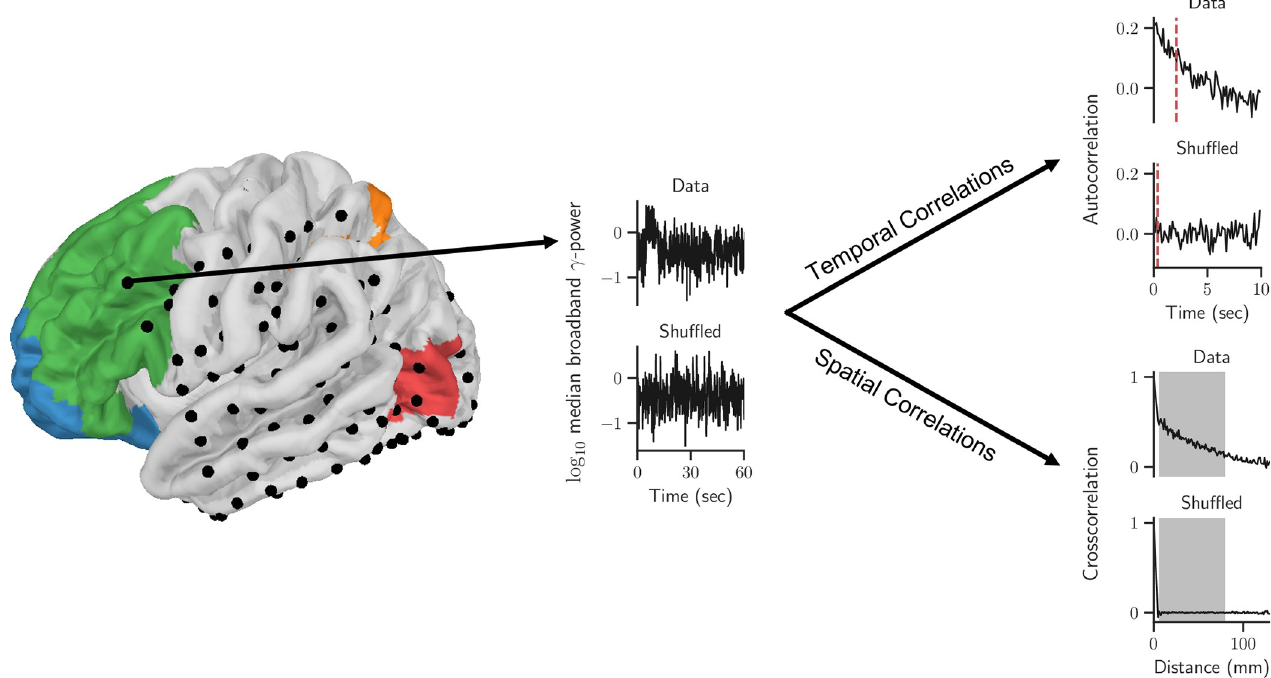
Fig 1. Topographical mapping of temporal and spatial correlations in cortex over extended periods of time. Left: Projection of invasive EEG electrodes from an exemplary subject with brain surfaces along the cortical hierarchy colour coded. Middle: γ -power timeseries for original and time-shuffled data. Right: Autocorrelation functions (top two panels) and cross-correlation functions (bottom two panels) are used to calculate temporal and spatial correlations, respectively.